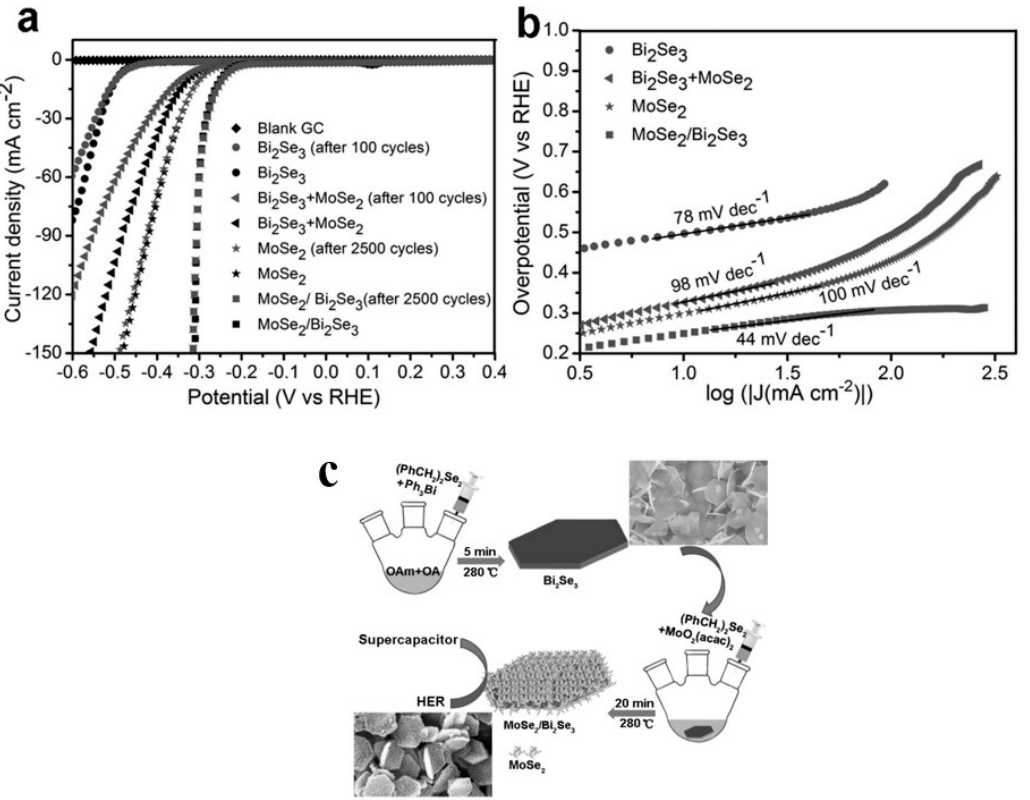
Figure 15. ( a ) Polarization curves, ( b ) Tafel slope, and ( c ) Schematic illustration for synthesis of MoSe 2 /Bi 2 Se 3 hybrids. [Reprinted with permission from reference [164]. Copyright 2017, John Wiley and